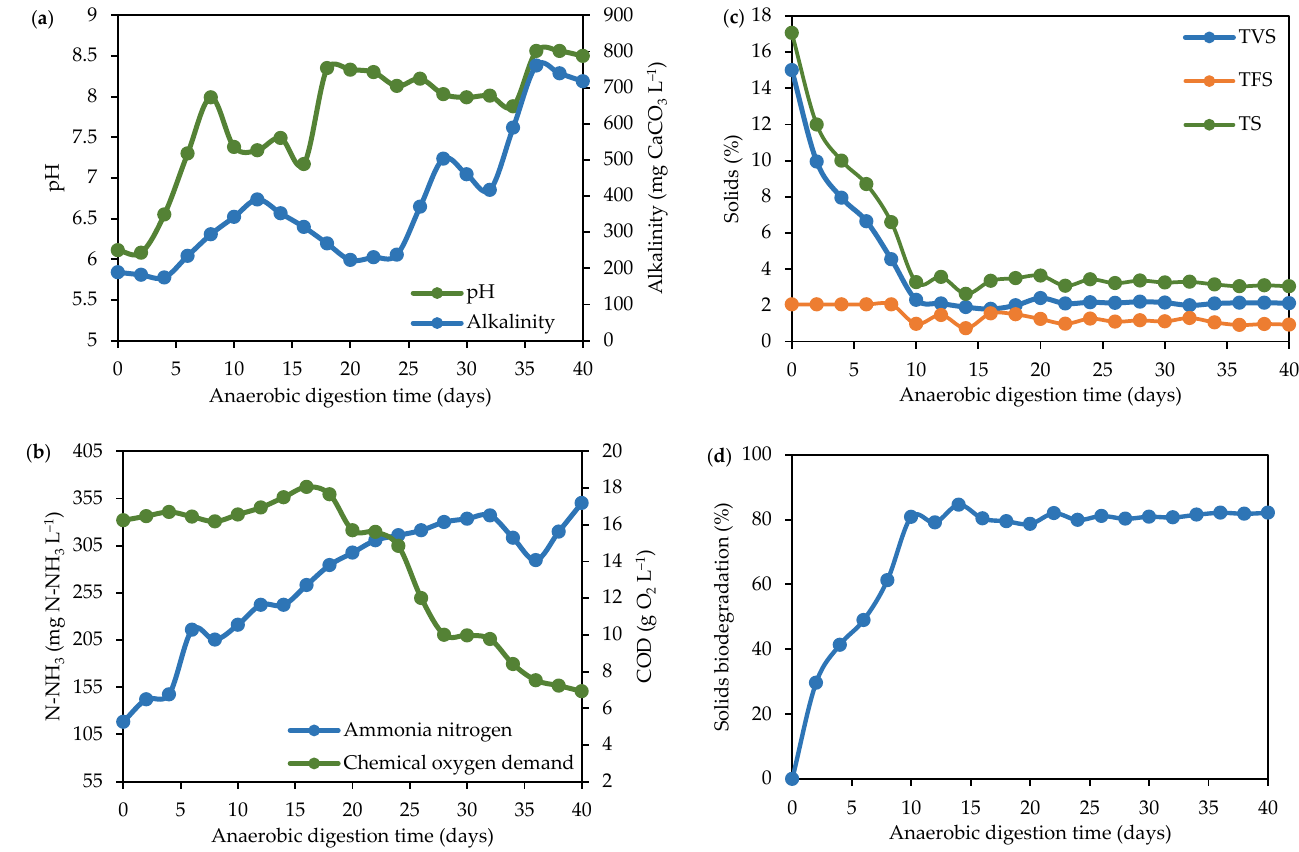
Figure 2. Operational parameters evaluated in the dry AD of BSG. ( a ) pH and alkalinity; ( b ) ammonia nitrogen and chemical oxygen demand; ( c ) solids; and ( d ) solids